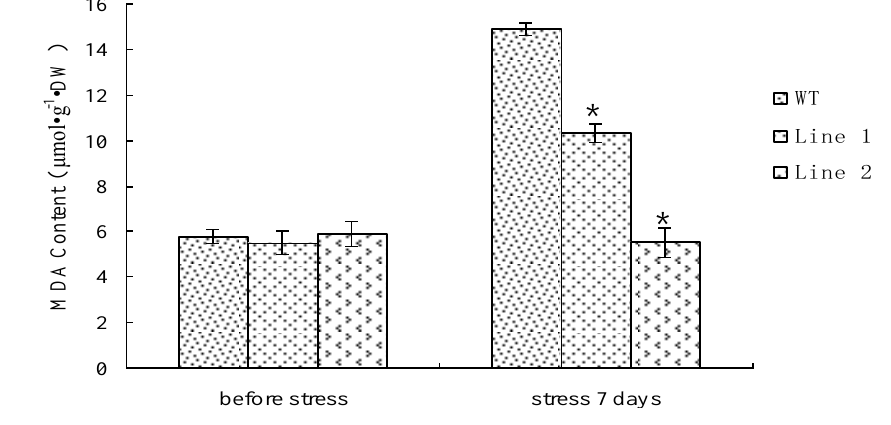
Figure 6. Analysis of malondialdehyde (MDA) level in the TaLEA1 transformed and WT poplar lines. MDA level was determined before stress and after 100 μM CdCl 7 days. Values are expressed as means ( n = 9 plants); error bars denote SD. * Significant ( t test, P < 0.05) difference compared with WT